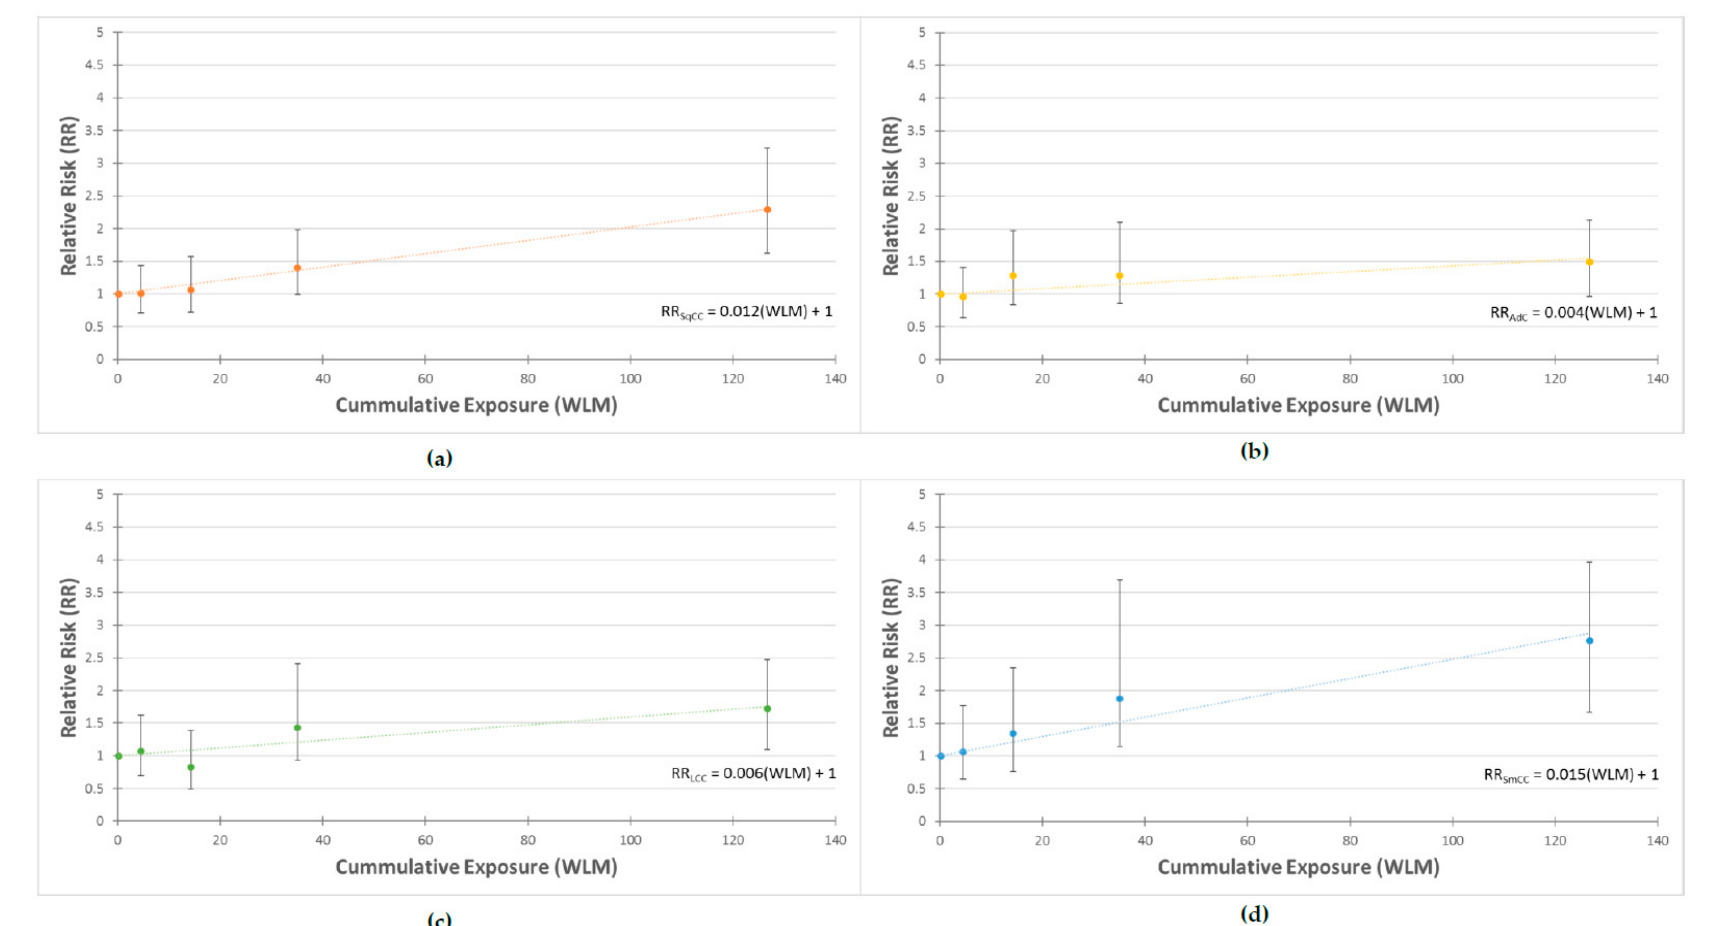
Figure 1. Excess relative risk by lung cancer histology groups, with 10-year lag applied and adjusted for attained age and calendar period: ( a ) Squamous cell lung carcinoma; ( b ) Adenocarcinoma; ( c ) Large cell lung carcinoma; ( d ) Small cell lung carcinoma.